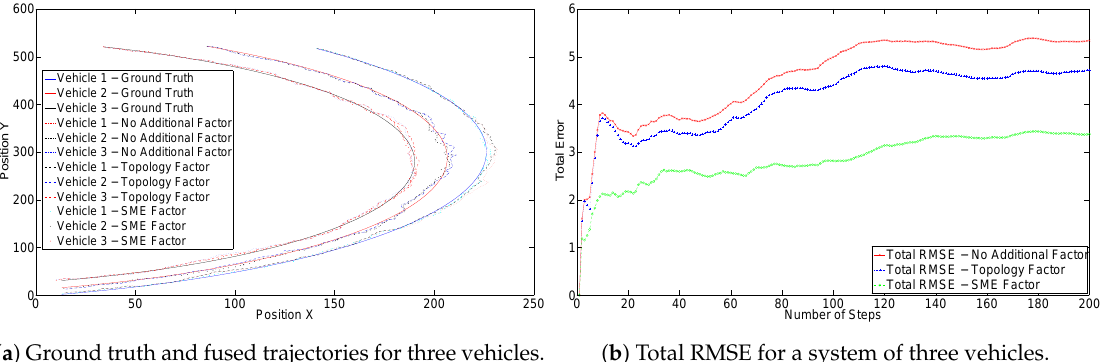
( b ) Total RMSE for a system of three vehicles. Figure 7. Second set with GPS for three trajectories with constant turn